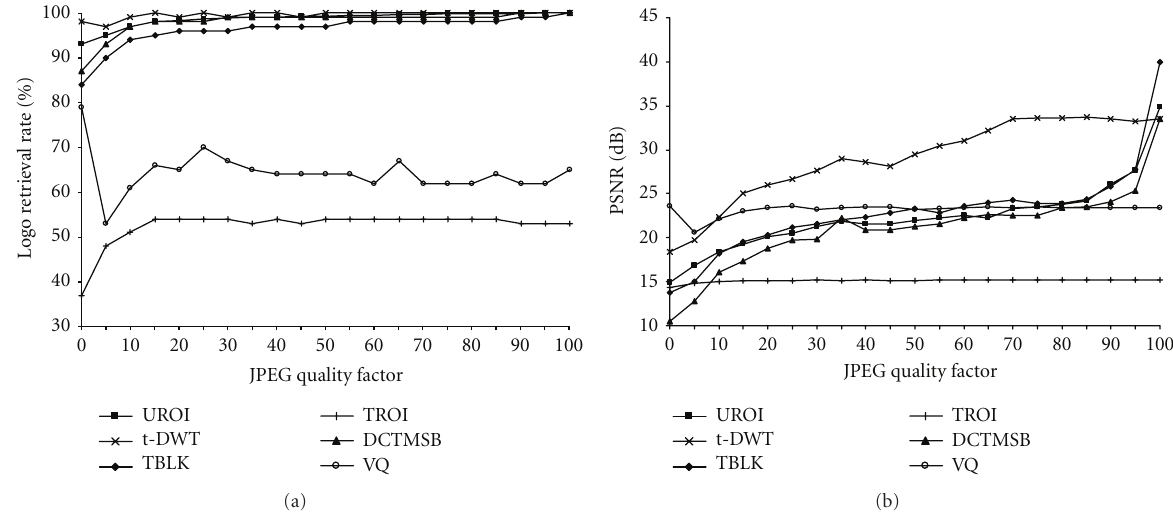
Figure 4: (a) Logo retrieval rate and (b) PSNR using Lena image and Monash logo by di ff erent approaches of the proposed MSB-based scheme and existing TROI-based [12] and VQ-based [13] schemes under di ff erent JPEG quality